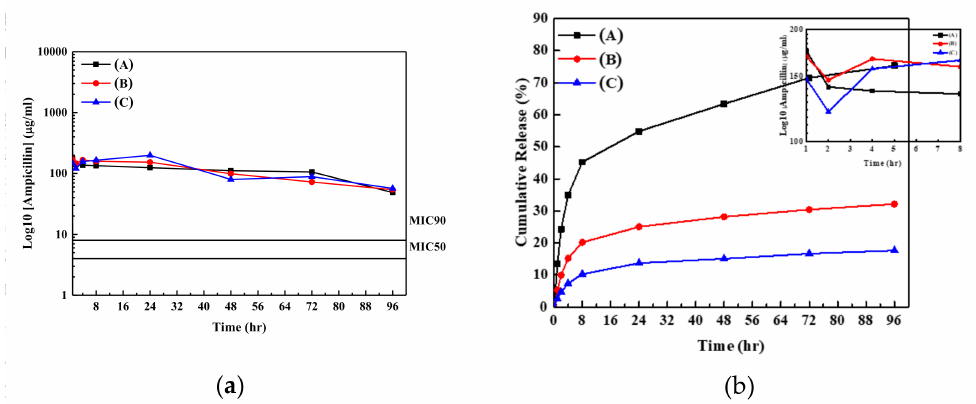
Figure 3. ( a ) Release profiles and ( b ) the cumulative amounts of ampicillins released from samples (A–C) into the bu ff er solution as a function of